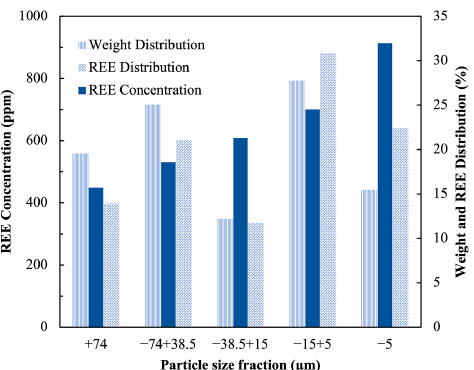
Figure 3. Concentration and distribution of REEs in the CFA sample by size fraction.